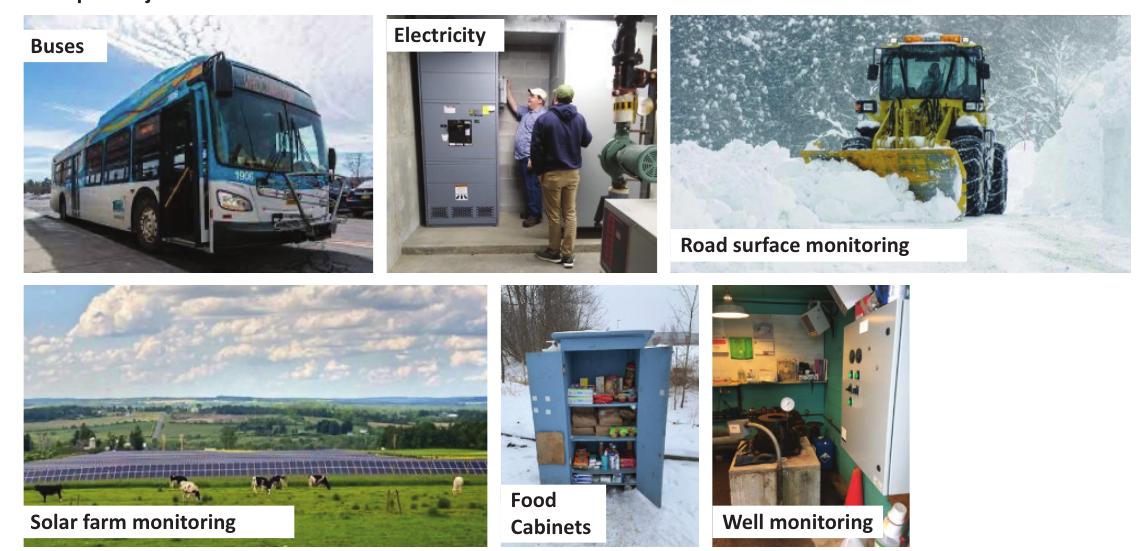
Figure 3. Slide of example “use cases” from community workshops. LPWAN landscape that shape network